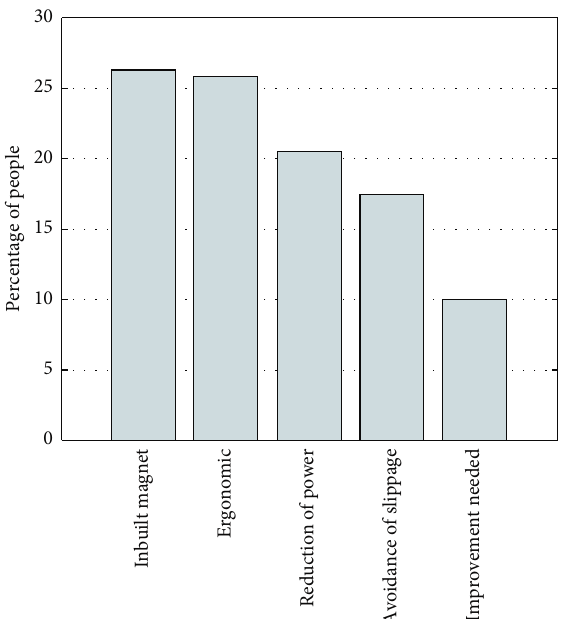
Figure 4: Recommendations to improve the existing tool.